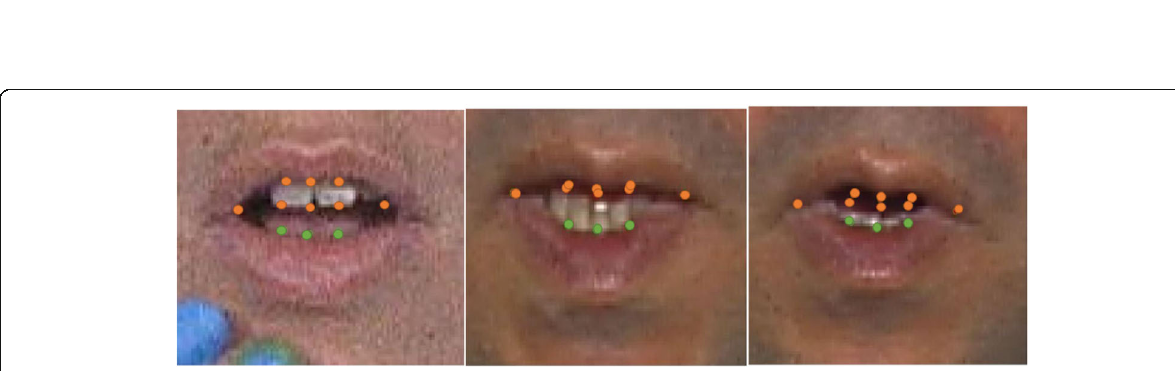
Fig. 14 Examples showing initial mistaken CLNF landmarks ( orange points ) and corrected landmarks using the proposed method ( green points ) for the inner lower